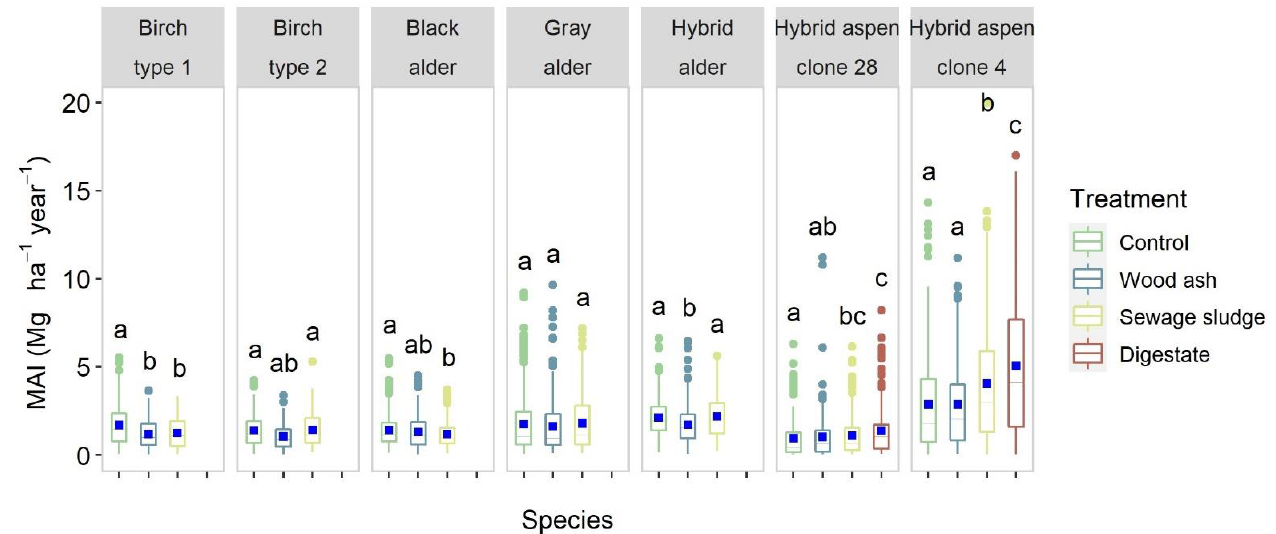
Figure 1. Mean annual increments (MAI) of dry above-ground biomass of eight-year-old fast-growing tree species stands depending on fertilization treatment (boxes represent interquartile range; median is shown as center horizontal line in the box; whiskers show minimum and maximum observed values; dots show outliers; mean values are represented by the blue squares; different letters represent significant ( P < 0.05) differences among treatments within each species).